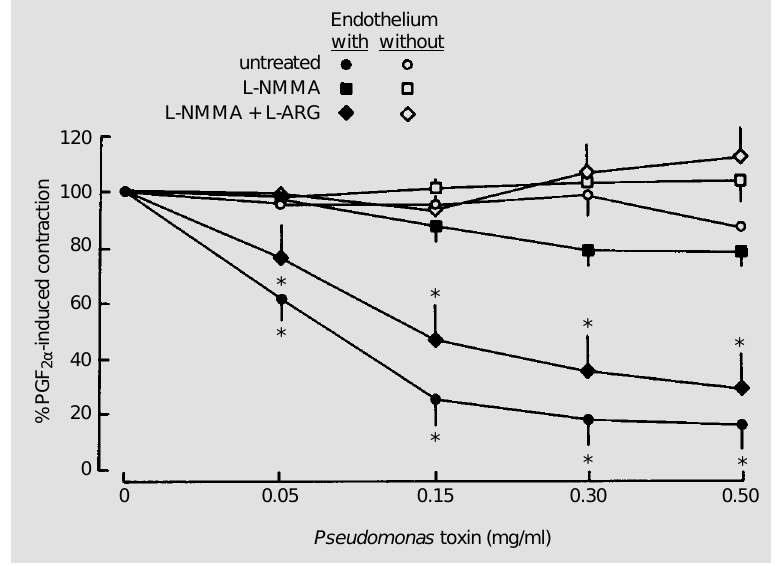
Figure 2 - Concentration-response relationship for Pseudomonas aeruginosa lipopolysac- charide in canine coronary arteries (N = 6 per group). Segments were contracted with 2 µM prostaglandin F 2 a (PGF 2 a ) (initial tension) and exposed to increasing concentrations of endotoxin (0.05-0.50 mg/ml). Results are reported as means ± SEM. L-NMMA denotes the presence of 10 µM N G -monomethyl-L-arginine. L-NMMA + L-ARG denotes the presence of 10 µM N G -monomethyl-L-arginine and 100 µM L-arginine. *P<0.05 compared to the initial tension of coronary artery segments (Student t